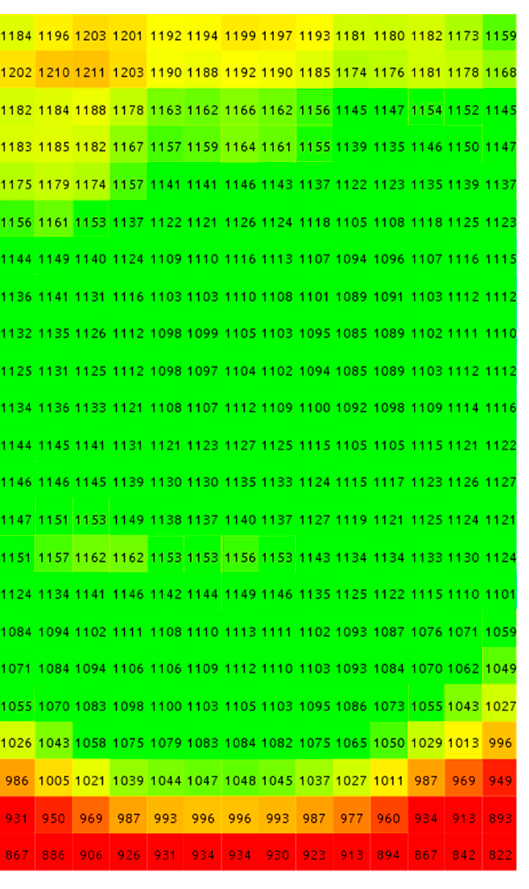
Figure 13. Distribution of solar radiation intensity on the surface comprising the tested samples. Location of lamps perpendicular to the tested samples. Minimum intensity 822W / m 2 , maximum 1211 W / m 2 , medium 1104 W / m 2 . Table 3. Temperatures as a function of the changes in solar radiation intensity read in the measurement fields of the thermogram made for the laboratory stand (Wind speed v = 0 m /